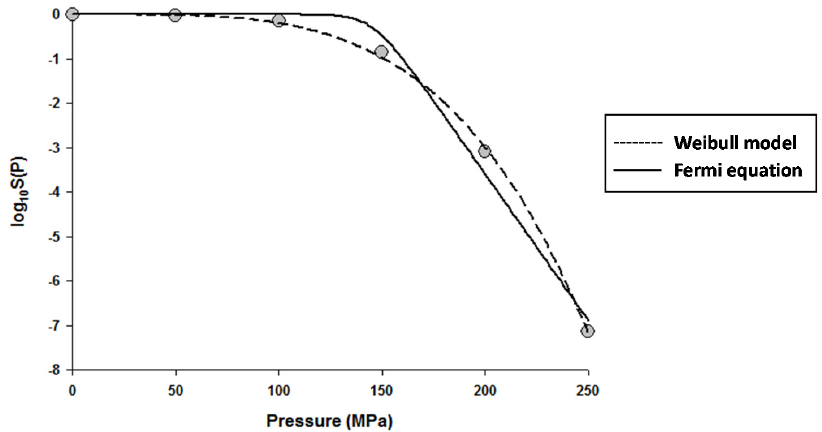
Figure 2. Dose–response curve of Saccharomyces cerevisiae in de Man, Rogosa and Sharpe (MRS) broth exposed to high hydrostatic pressure (HHP) at 25 °C for 10 min. Data were fitted with the Weibull model (dashed lines) and the Fermi equation (solid lines). Original data were taken from Donsì et al. [20].